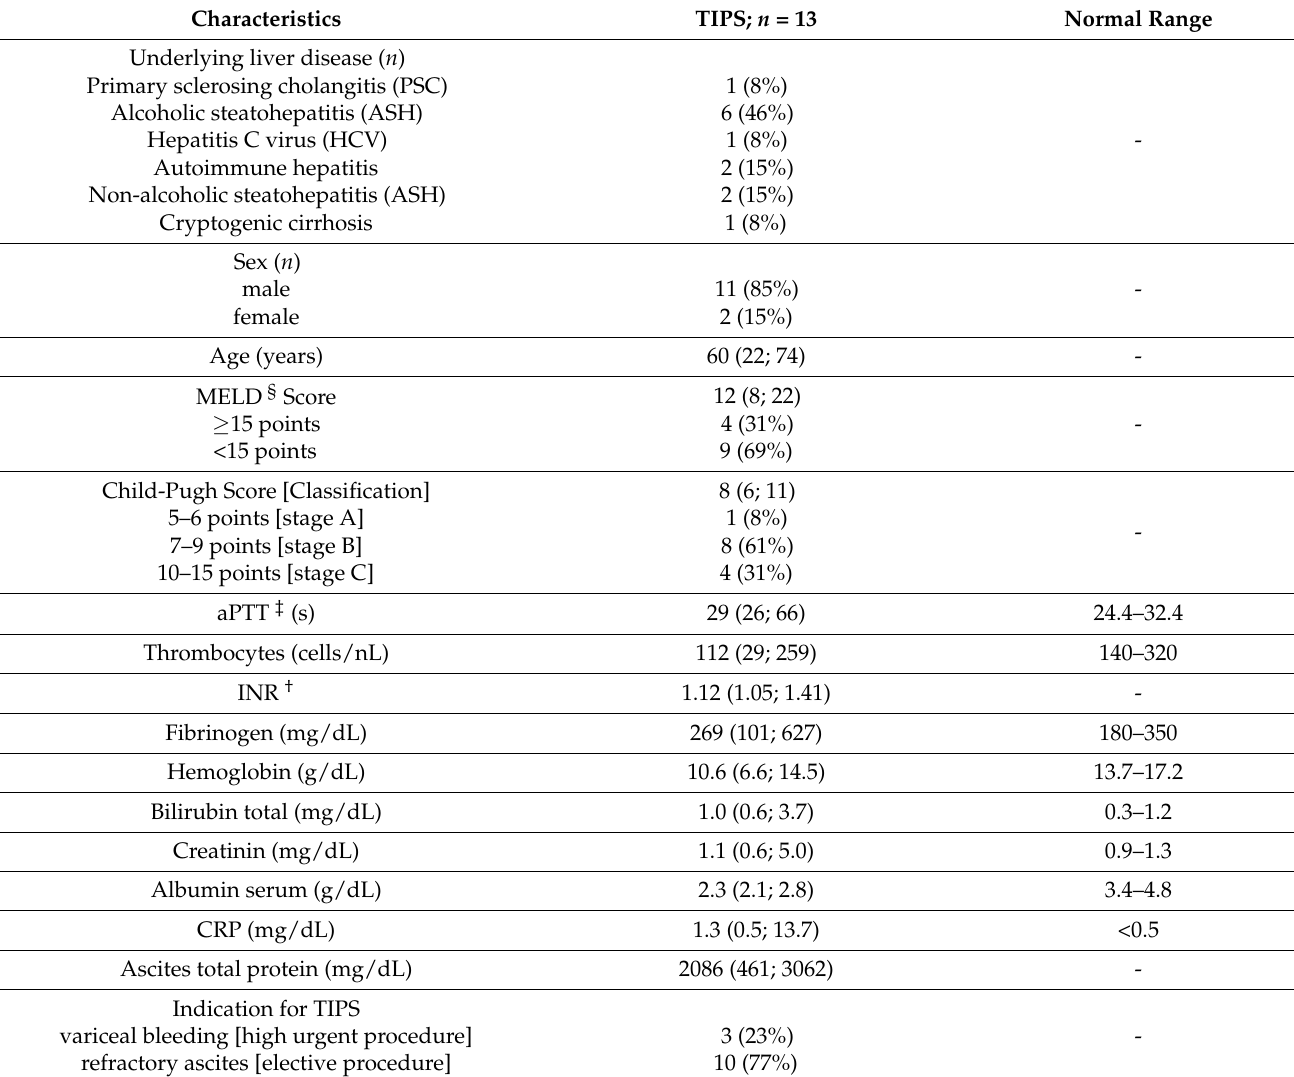
Table 1. Demographic characteristics and clinical parameters of patients undergoing TIPS. Data are presented as median (min; max) or as absolute count “ n ” with percentage